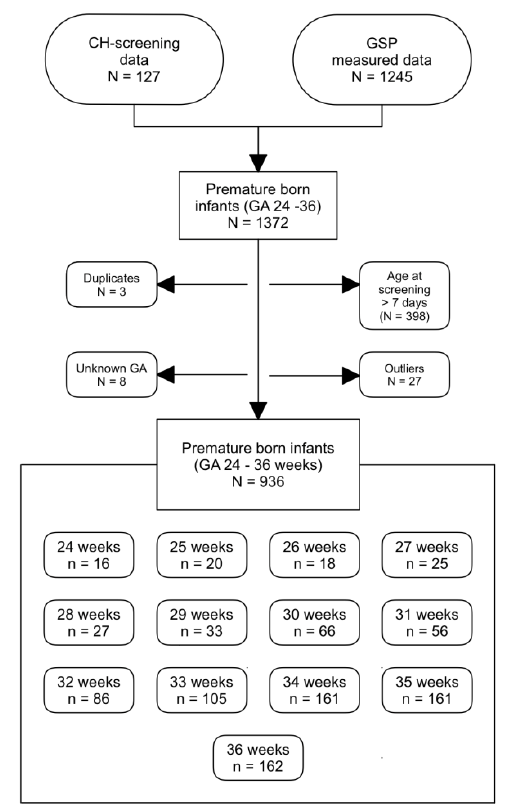
Figure 1. Data selection for the study. Outliers were determined using SPSS. GA: gestational age, GSP: GSP Neonatal Thyroxine (T4) kit.